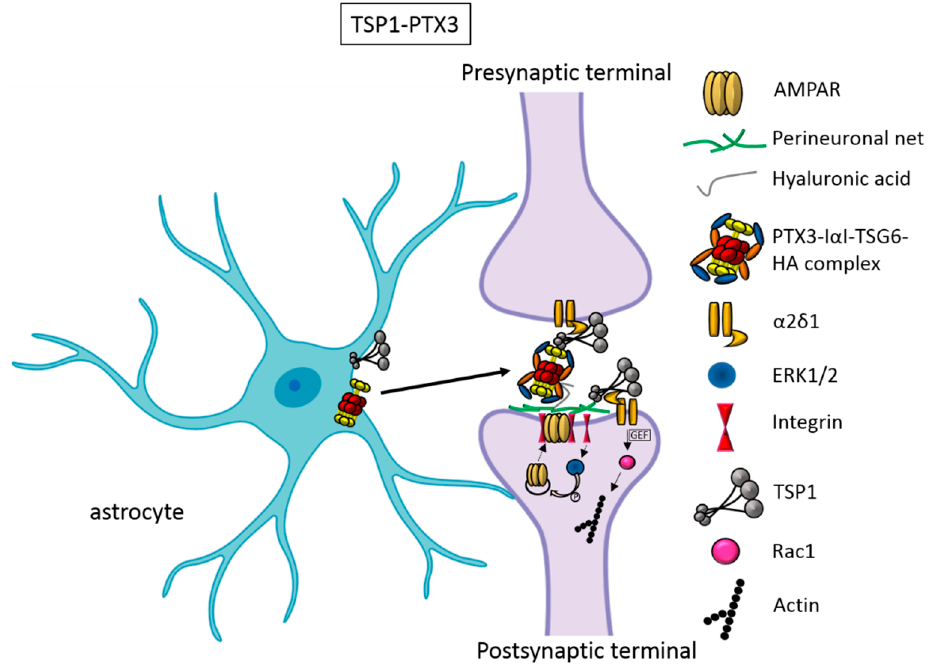
Figure 1. TSP1 and PTX3 cooperate to promote early formation of functional excitatory synapses. TSP1 binds to the α 2 δ 1 receptor on the presynaptic terminals stimulating an increase in structurally normal but silent synapses, and to the α 2 δ 1 receptor at the postsynaptic site, activating Rac1 and stimulating actin remodeling to promote spinogenesis. PTX3 promotes the functional maturation of these synapses by recruiting AMPA receptors at the synapse.